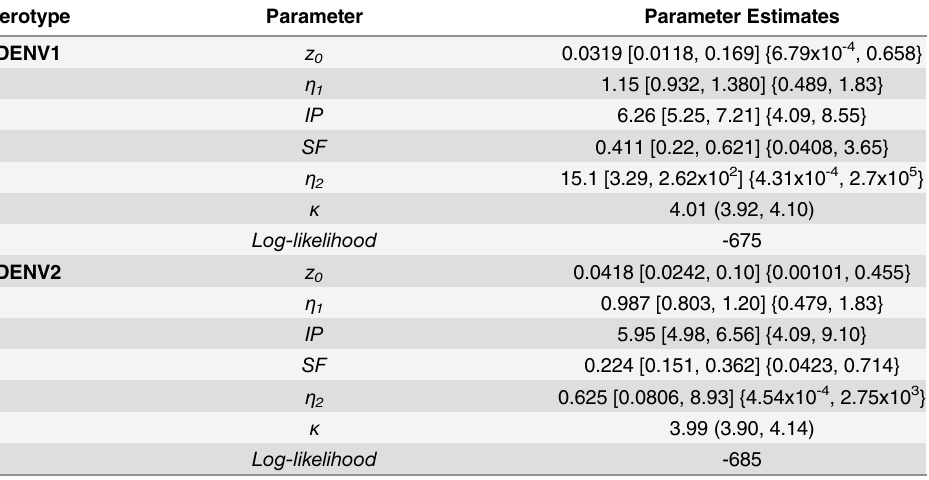
Table 3. Parameter estimates for the model with ADCC, in which antibody removes infected cells (Model 1). The model was separately fitted to IgM data for DENV1 and DENV2 infections. For patient specific parameters (i.e. the immune response parameters and the incubation period, IP), median [IQR] and {mini- mum, maximum} estimates across subjects are reported. For parameters assumed to be the same for all infections with the same serotype ( κ ), the median posterior estimate and 95% CI are reported. Parameters z 0 , η η 1 , 2 , IP and SF were fitted as patient-specific and others as common to all patients in the fitted group.